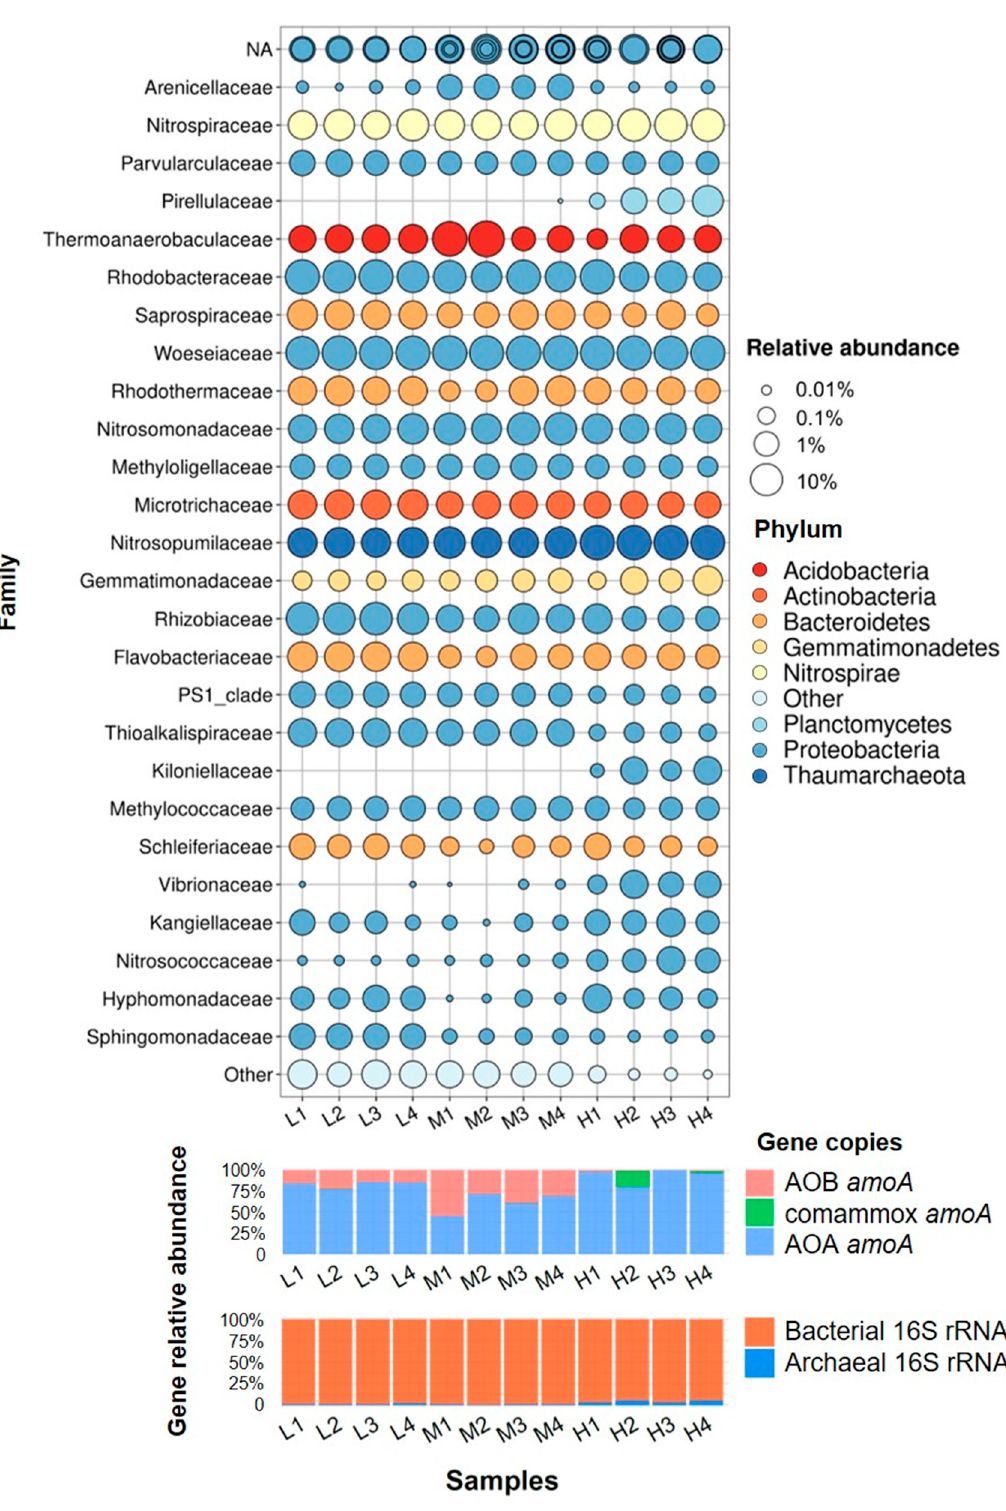
Figure 5. Relative abundance bubble plot of 16S-v4 gene profile at the family level ( up ), quantification results of amoA gene via qPCR ( middle ), quantification result of 16S rRNA gene via qPCR ( down ).